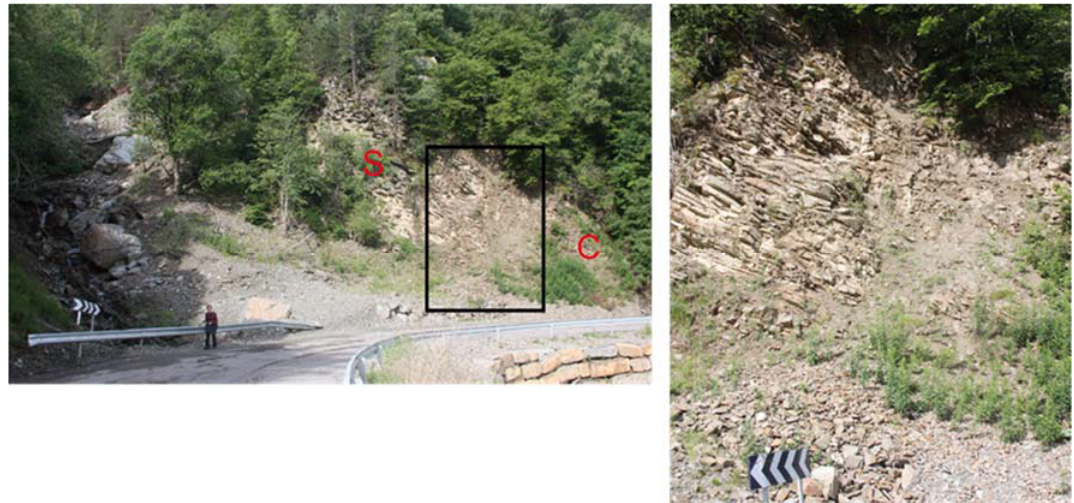
Figure 3. Regional cleavage of the Cambro–Ordovician bedrock subparallel to the topographic surface. Gradual transition from bedrock (S) to colluvium (C). The black square delineates the area in the right picture.